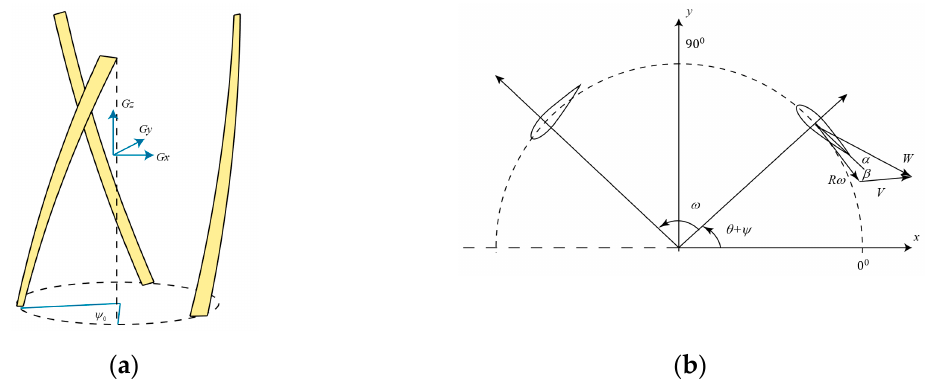
Figure 3. Schematic of the flow angles of a VAWT with helical blades. ( a ) side view; ( b ) top view.